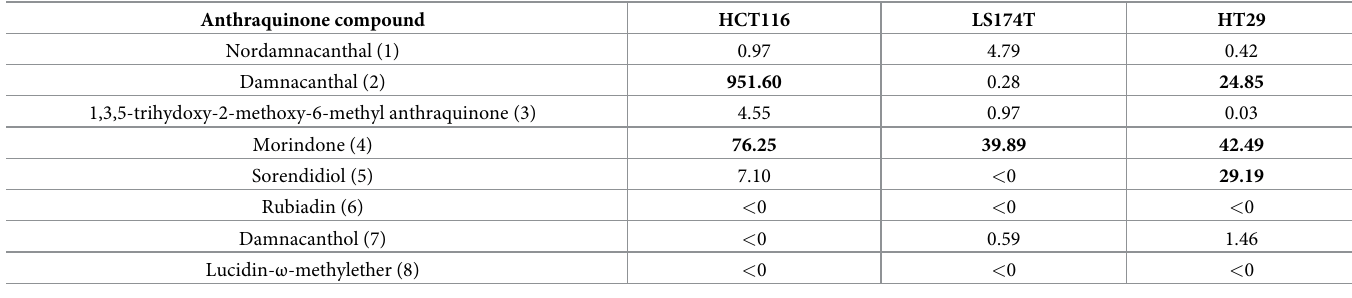
High SI values were highlighted in